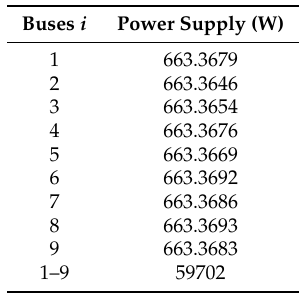
Table 5. The power supply on each bus in IEEE 9-bus system.